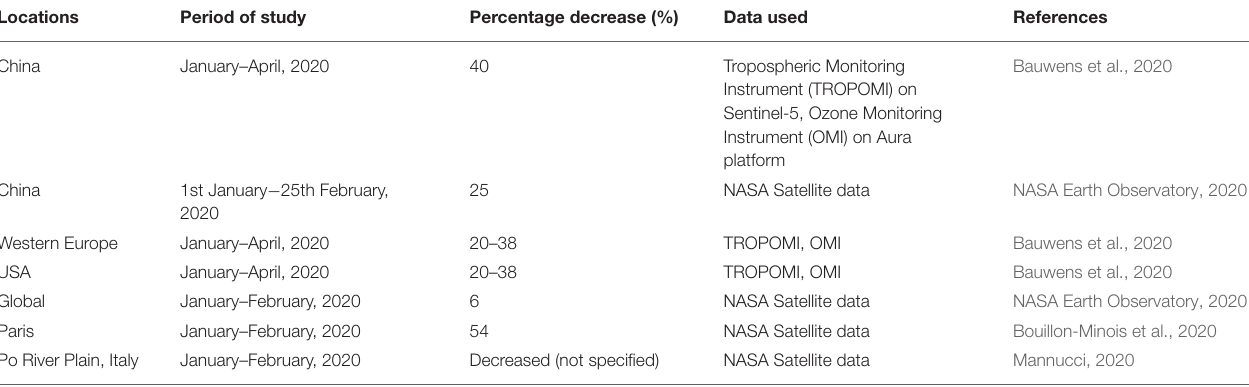
TABLE 1 | Decrease of air pollution (NO 2 ) across the globe during the Covid-19 lockdown period.